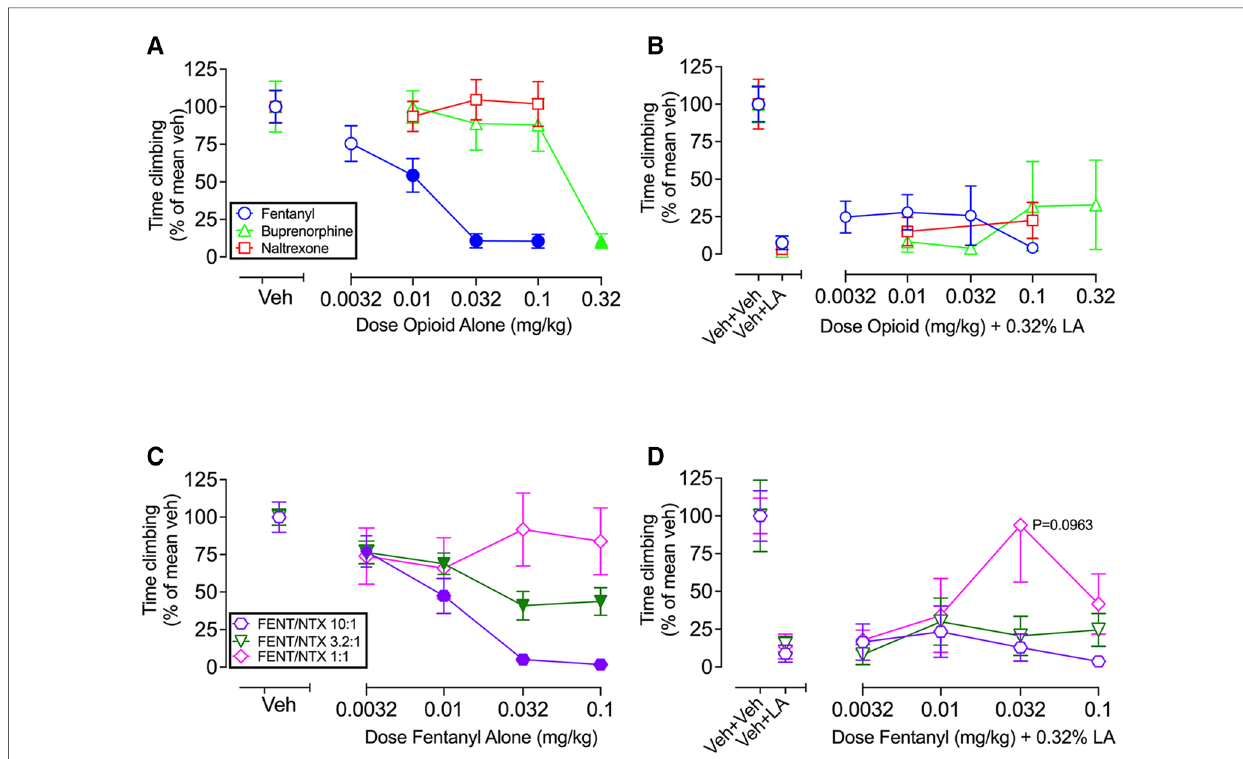
FIGURE 4 Effects of single-molecule opioids±IP acid, and fentanyl/naltrexone (FENT/NTX) mixtures±IP acid. ( A ) Effects of fentanyl, buprenorphine, and naltrexone administered alone. Abscissa: Dose of opioid alone in mg/kg. ( B ) Effects of fentanyl, buprenorphine, and naltrexone as pretreatments to IP 0.32% lactic acid. Abscissa: Dose of opioid in mg/kg. ( C ) Effects of 10:1, 3.2:1, and 1:1 FENT/NTX mixtures administered alone. Abscissa: Dose of fentanyl alone in mg/ kg, with naltrexone dose varying according to the designated proportion. ( D ) Effects of 10:1, 3.2:1, and 1:1 FENT/NTX mixtures as pretreatments to IP 0.32% lactic acid. Abscissa: Dose of fentanyl in mg/kg, with naltrexone dose varying according to the designated proportion. For all panels, the ordinate is time climbing expressed as percentage of the mean climbing time after vehicle (Veh in A,C; Veh+Veh in B,D) in that group, and all bars and points show mean±SEM from 12 mice, except for FENT/NTX 10:1+IP lactic acid ( N =11). Filled points in panels A and C indicate a signi fi cant difference from “ Veh ” , P <0.05. Drug effects in Panels B and D were compared to Veh+LA by one-way ANOVA (Veh+Veh data not included in analysis), and no drug effects were signi fi cant. Panel D shows that the one-way ANOVA for the 1:1 mixture approached the criterion for signi fi cance ( P =0.0963), and a Dunnett ’ s post hoc test indicated a P -value of 0.1724 in comparing Veh+LA with the 0.032 mg/kg Fentanyl/0.032 mg/kg Naltrexone